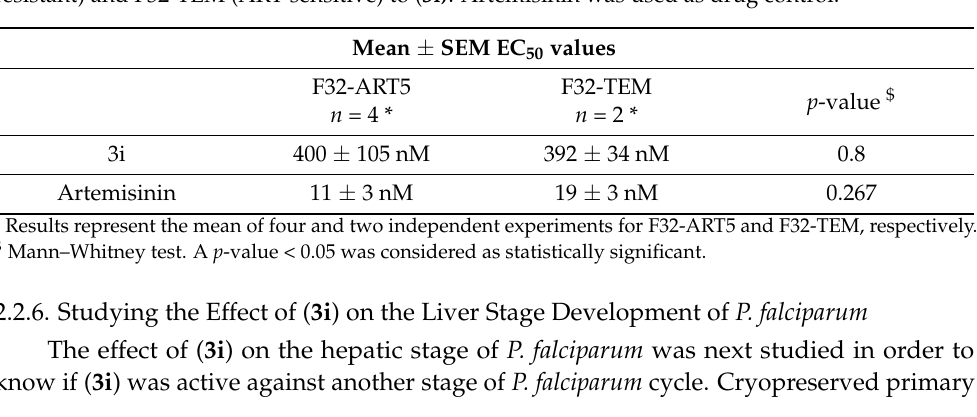
Table 4. Evaluation of chemo-sensitivity, by standard assay, of P. falciparum strains F32-ART5 (ART- resistant) and F32-TEM (ART-sensitive) to ( 3i) . Artemisinin was used as drug